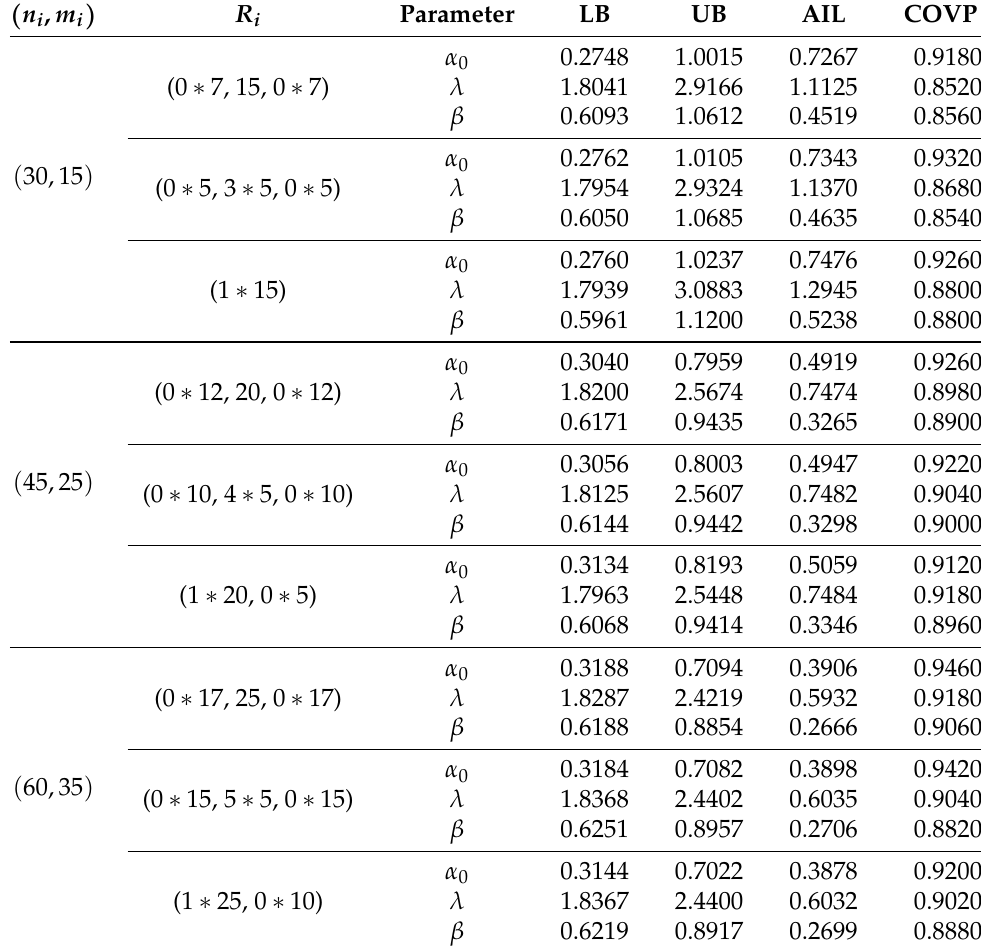
Table 5. The lower bounds (LB), upper bounds (UB), average interval lengths (AIL) and coverage probabilities (COVP) of the 95% bootstrap percentile confidence interval for different sample sizes ( n ) and different censoring schemes R i , m i i